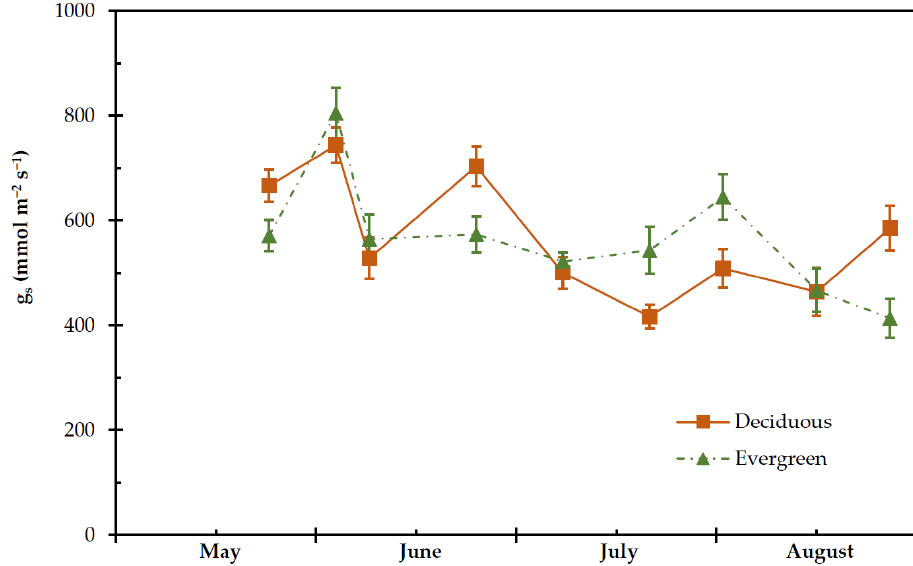
Figure 6. Seasonal stomatal conductance (g s ) of deciduous and evergreen shrubs during the experi- mental period, from 27 May to 28 August. The values are means ± SE ( n =